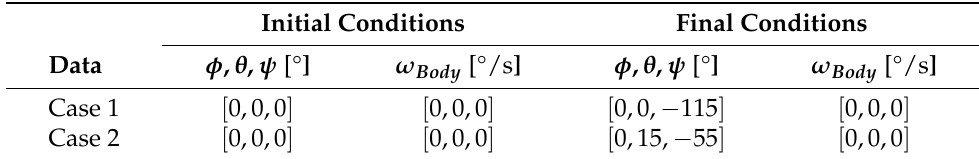
Table 2. Attitude maneuvers.